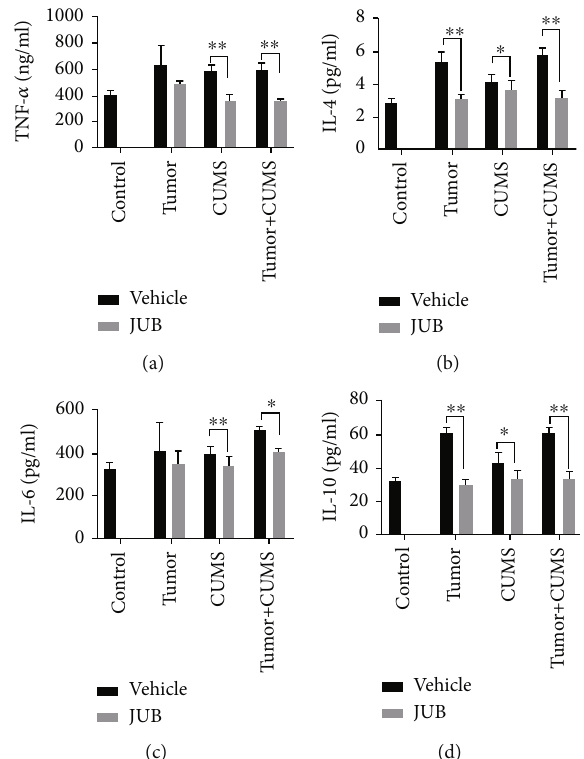
Figure 5: Expression of in fl ammatory cytokines of mice. (a – d) JUB decreased TNF- α and IL-4, -6, and -10 levels of LLC transplanted- bearing mice. Data are mean ± SD ( n = 8/group ). ∗ P < 0 : 05and ∗∗ P < 0 : 01